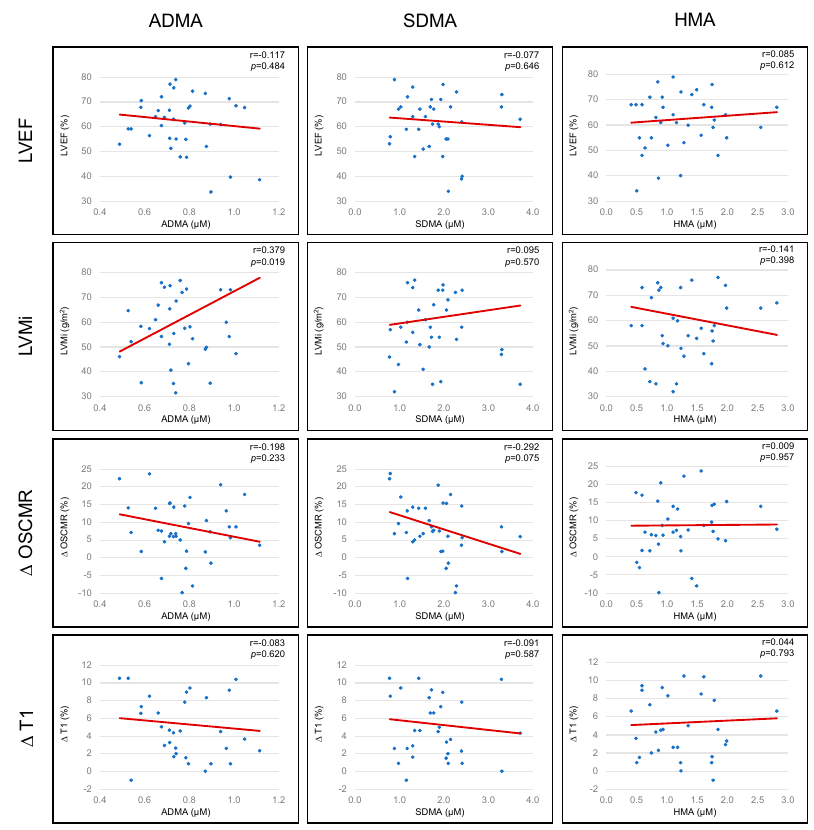
Figure 4. Association between arginine metabolites and cardiovascular magnetic resonance (CMR) derived parameters: LVEF, LVMi, stress OSCMR and stress T1.